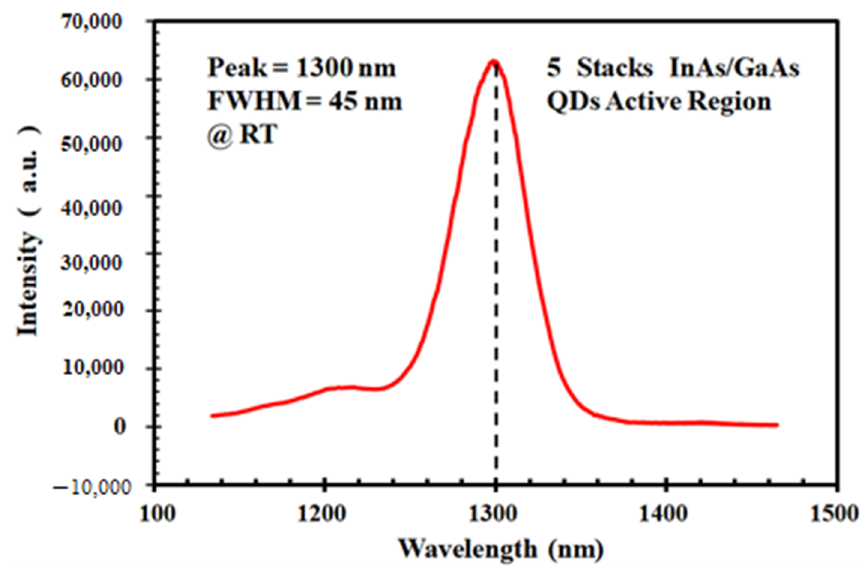
Figure 6. PL result of silicon-based InAs/GaAs quantum dot structure with peak at 1300 nm.